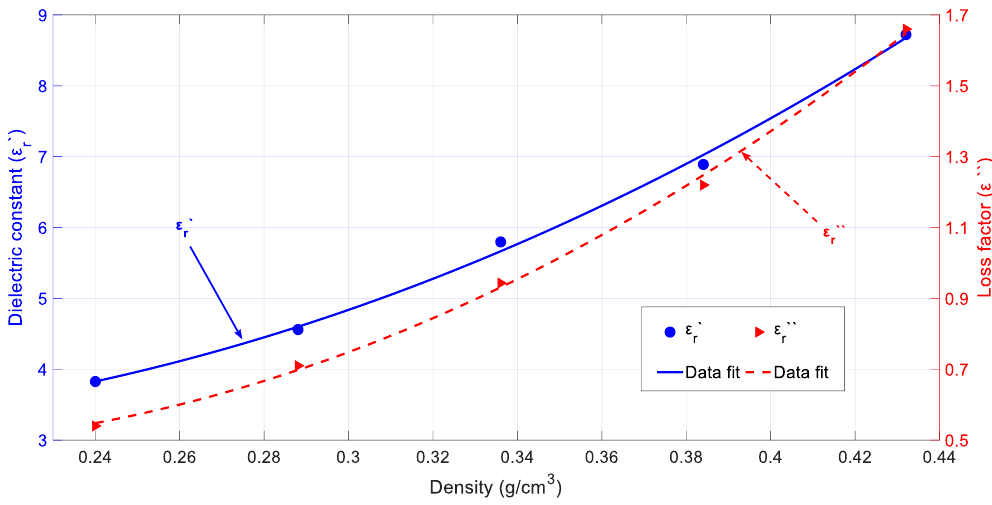
Figure 7. Dielectric properties’ measurements and polynomial data fit for rockrose depending on the sample density. Carried out at 28 °C and a moisture content (dry basis) of around 100%.